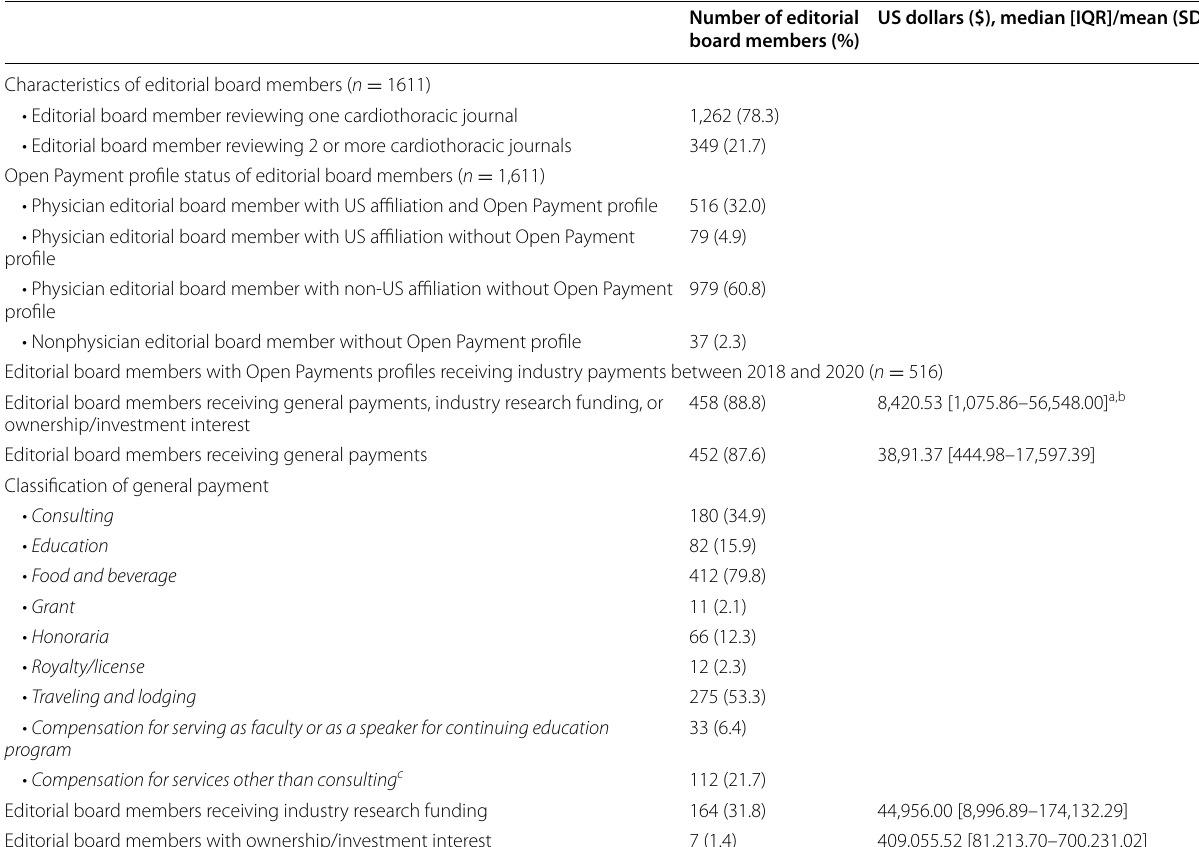
Table 1 Summary and financial associations of 1611 editorial board